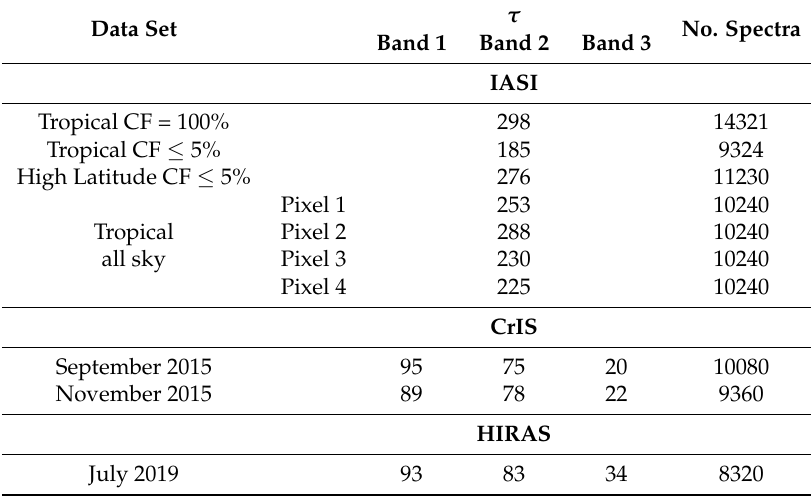
Table 3. Number of PC scores used in the analysis for the different instruments and datasets. For IASI, all bands are merged